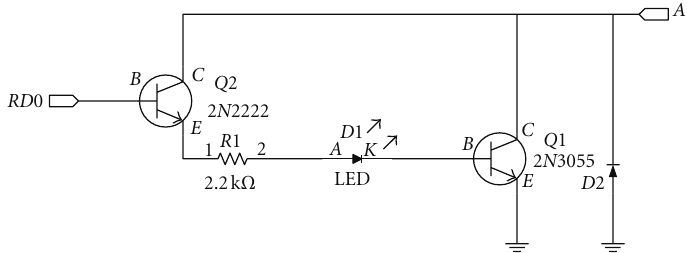
Figure 3: The driving circuits with a Darlington pair to drive one phase of the step motor.